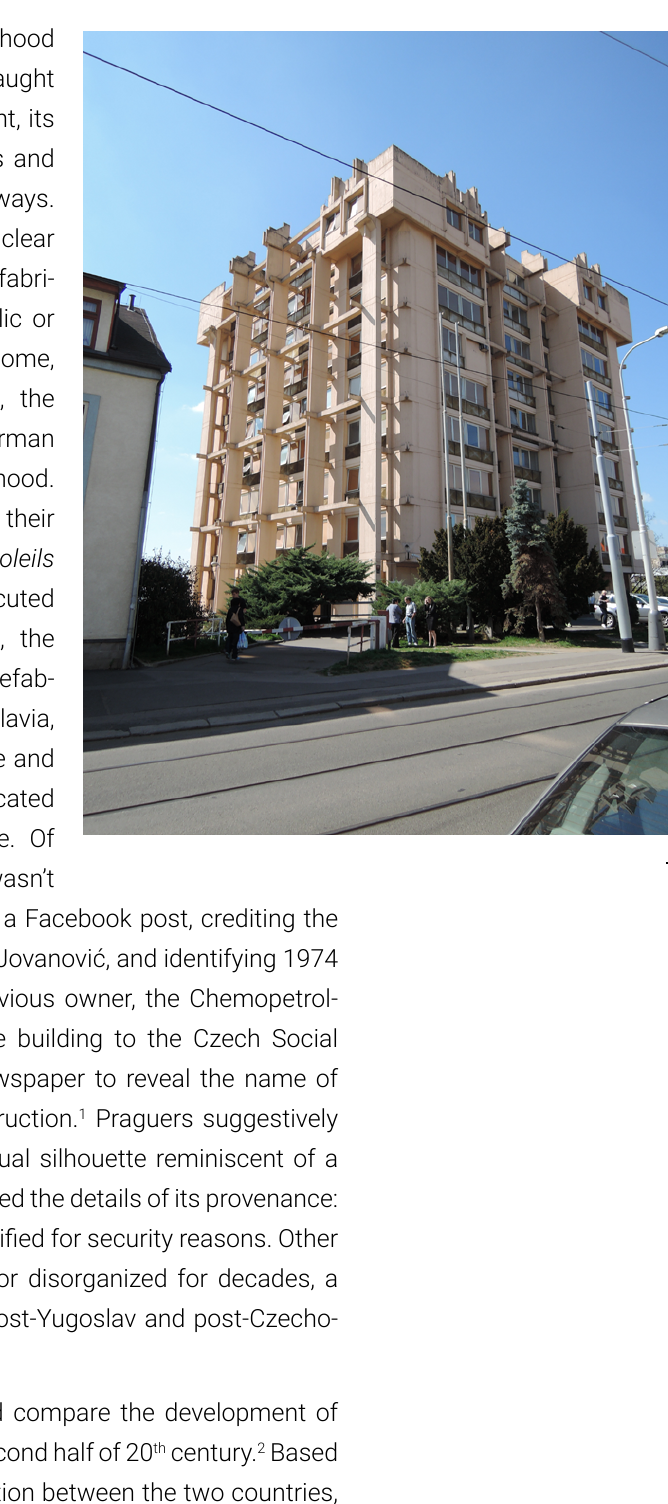
Architect Jovan Jovanović, Former building of the Chemo- petrol-Benzina Company, today Czech Social Security, popu- larly named Drákulov, Kobilisy, Prague, 1974-1979 (Photo: Jelica Jovanović,